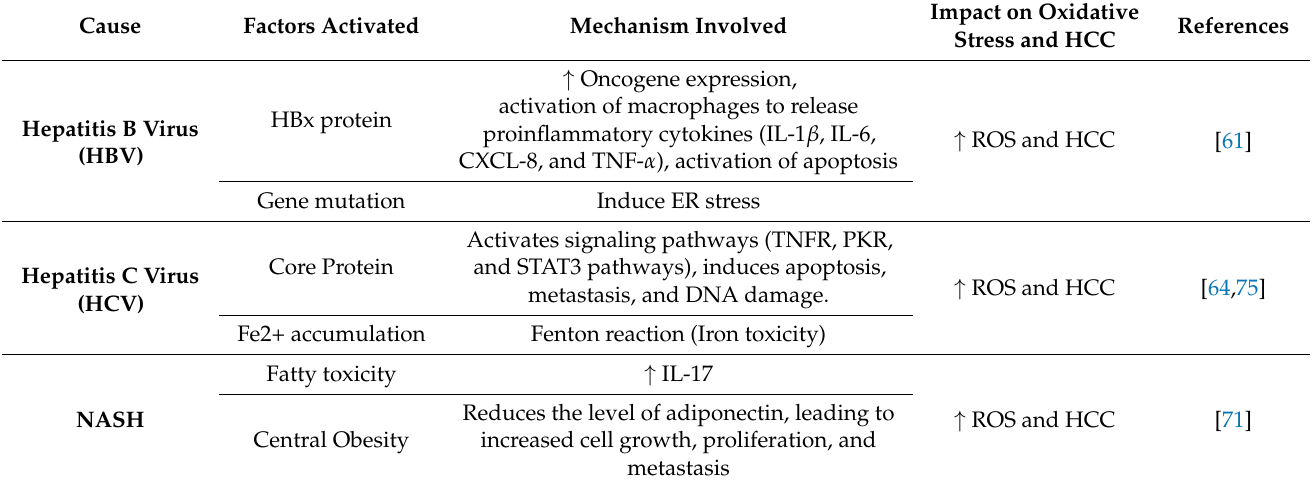
Table 1. Role of oxidative stress on HCC and associated